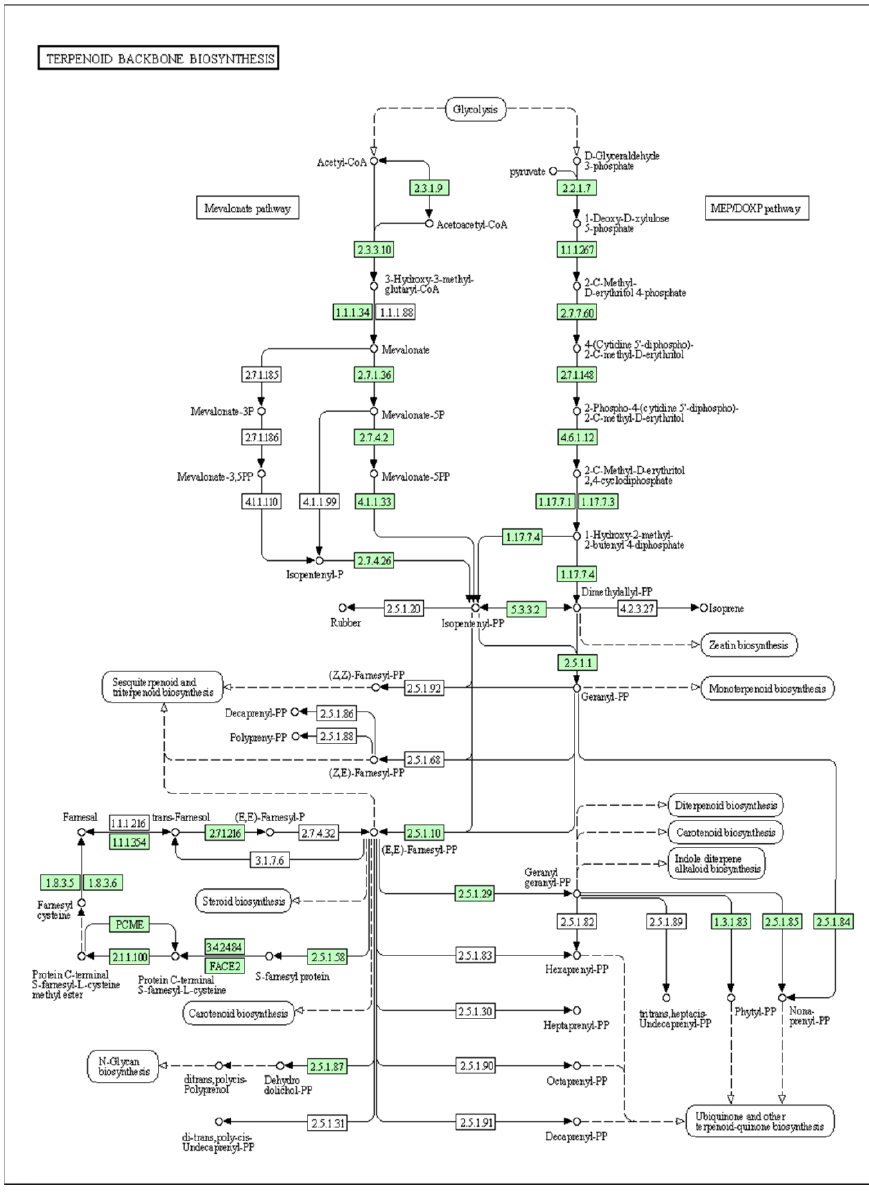
Figure 9. The terpenoid biosynthesis pathway in Hoya species based on KEGG database.